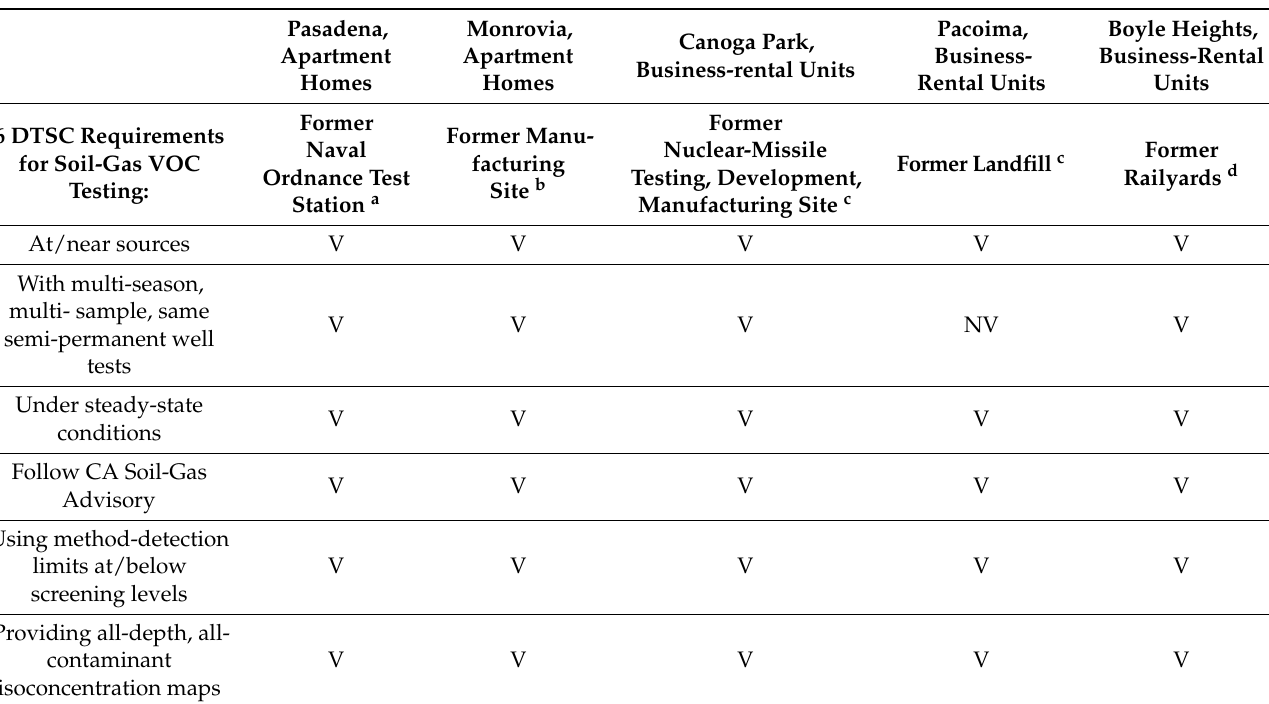
Table 7. VOC-testing violations (V) or no violations (NV), 5 California redevelopments of hazardous